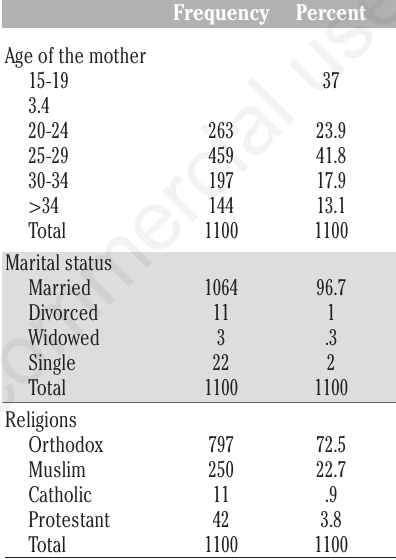
Table 1. Distribution of age, marital status and religion of mothers at DBRH from